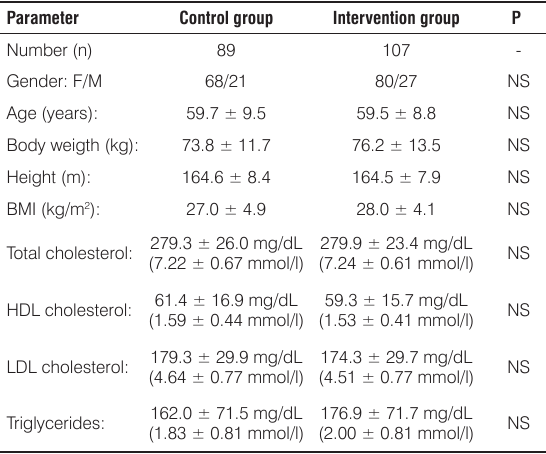
Table 1. Characteristics of the studied